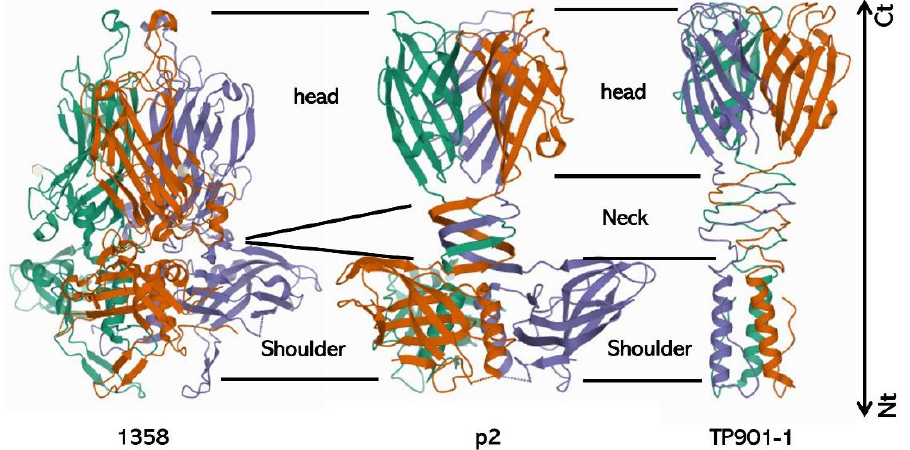
Figure 8. Structure of lactococcal RBP. Most lactococcal RBP harbor a three-domain organization with an N-terminal (Nt) shoulder domain, which attaches the RBP to the virion, a central connecting neck domain, and a C-terminal (Ct) head domain involved in receptor recognition. In some phages (e.g., 1358), the neck domain is absent. Each protein monomer is displayed in a different color. Structures were retrieved from the Protein Data Bank (1358: PDB ID 4RGA and [152]; p2: PDB ID 2BSD and [153]; TP901-1: PDB ID 3EJC and [134]).